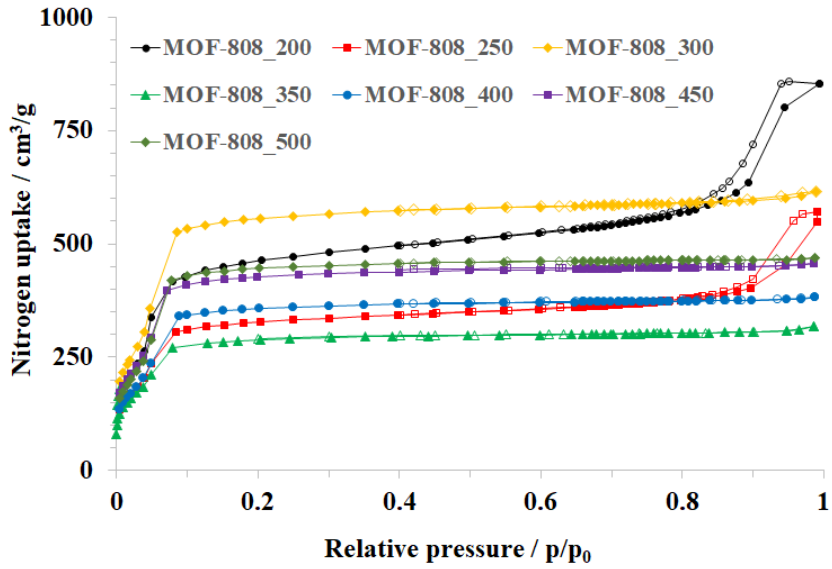
Figure 4. Nitrogen physisorption isotherms of MOF-808 samples synthesized with various amounts of formic acid.